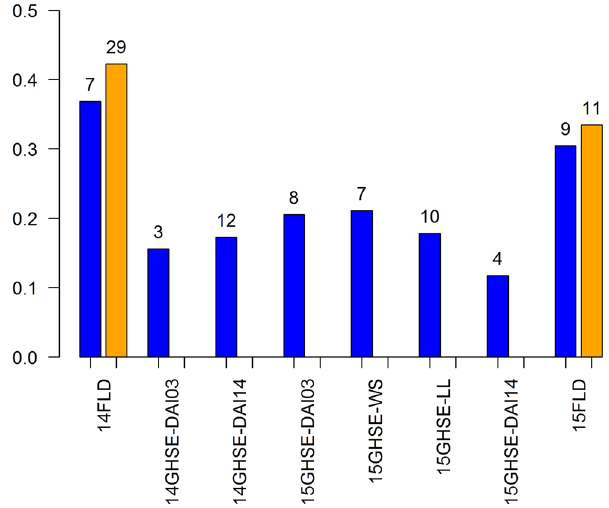
Figure 1. Contributions to the phenotypic variance of identified Sclerotinia stem rot loci via genome-wide association and epistatic analyses for each environment and trait. The number of loci and/or pair of loci used to estimate contributions are indicated above each bar. Blue bars represent contributions due to loci identified using GWAS and orange bars represent contributions of both loci identified using GWAS and loci interactions identified using